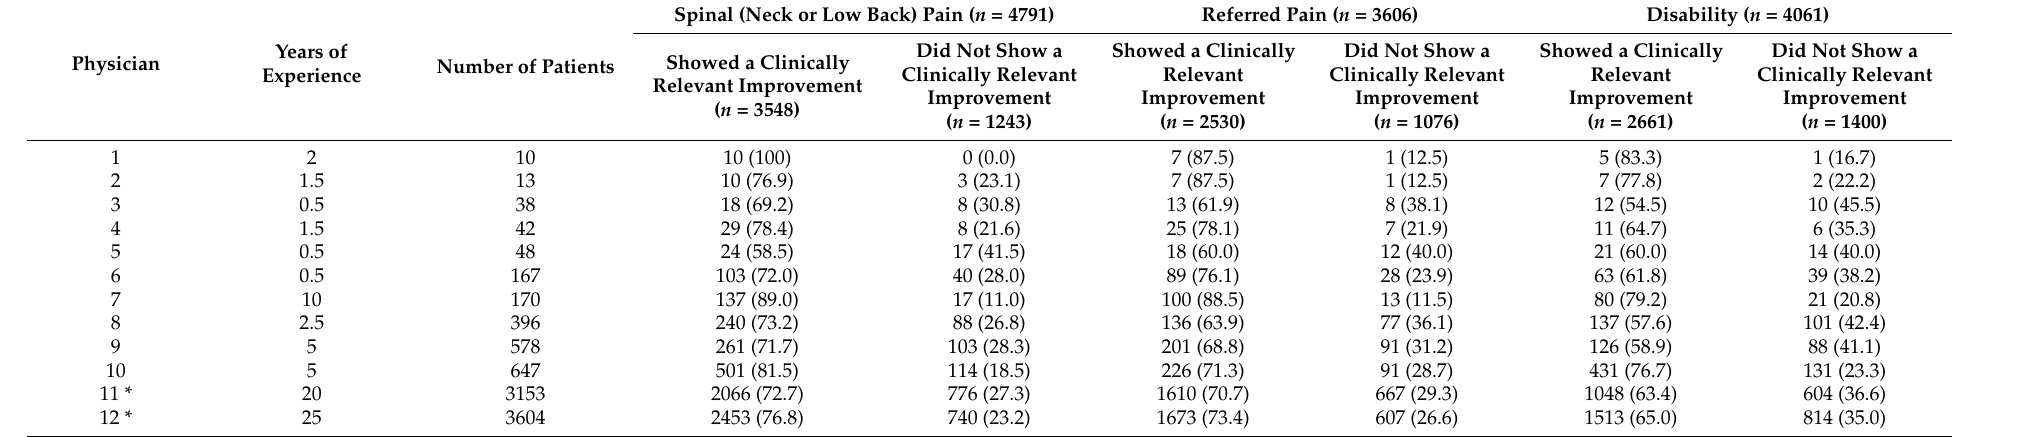
Table 1. Results obtained by each physician.